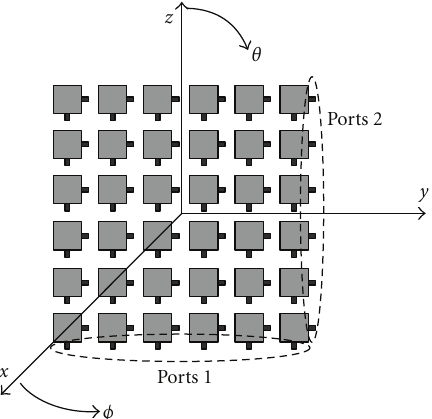
Figure 1: Illustration of y , z plane located planner phased array antenna comprising dual-polarized radiation